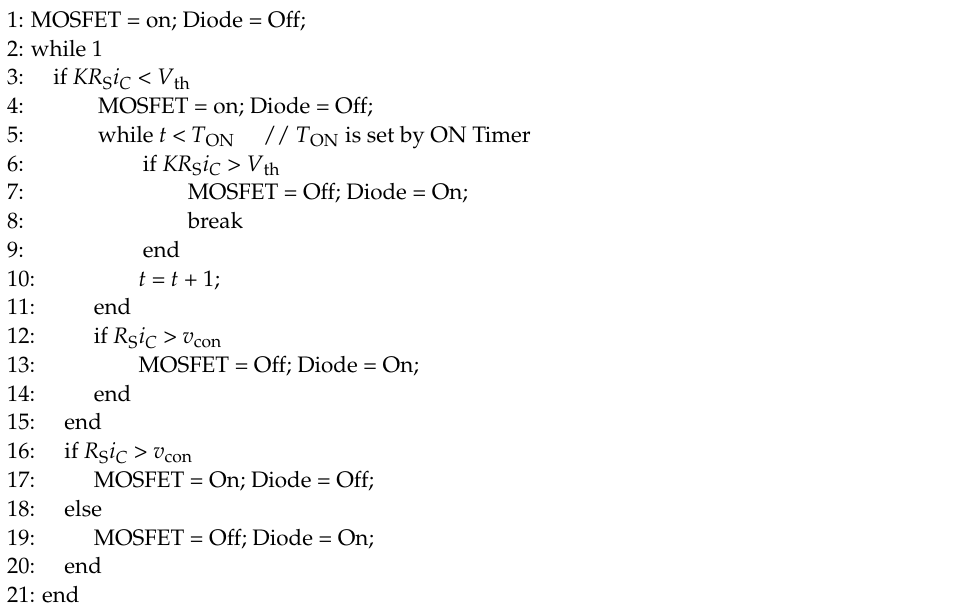
Algorithm 2: Workflow of the Improved CC-COT